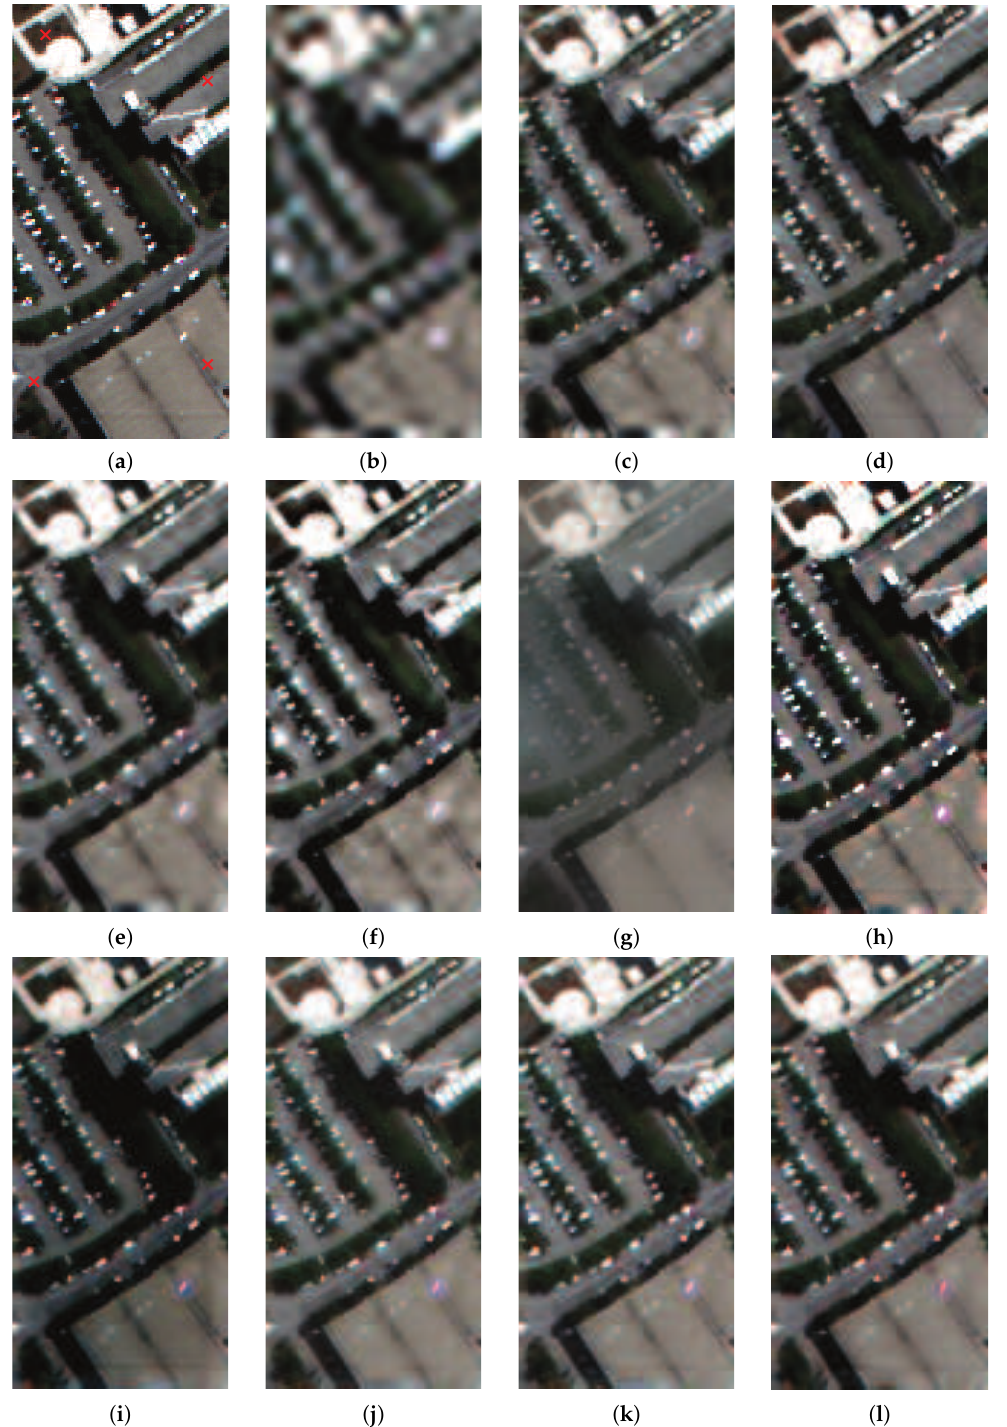
Figure 7. Pansharpening results for the Pavia dataset: ( a ) ground truth; ( b ) EXP; ( c ) SFIM; ( d ) CNMF; ( e ) MTF-GLP-HPM; ( f ) GSA; ( g ) GFPCA; ( h ) Bayesian Sparse; ( i ) PNN; ( j ) DRPNN; ( k ) DiCNN1; and ( l )